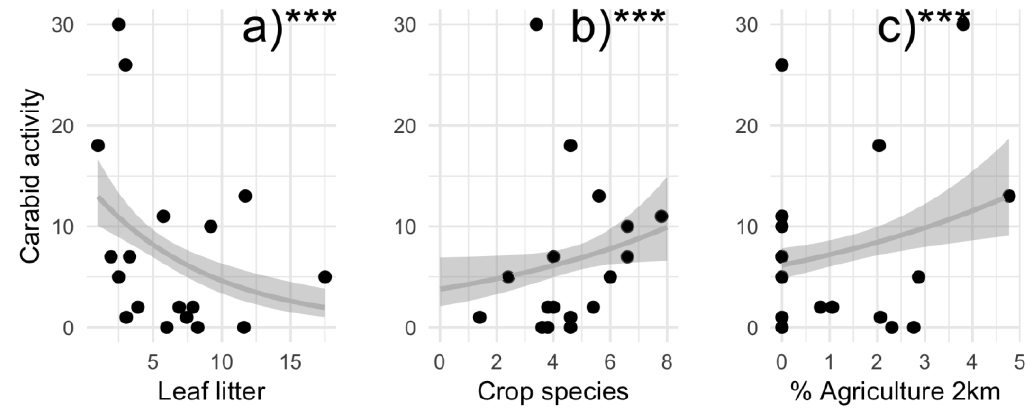
Figure 1. Local and landscape drivers of carabid activity density in urban gardens in the California central coast as determined with generalized linear models. Carabid activity responded to leaf litter ( a ), crop species richness ( b ), and agriculture land cover within 2 km surrounding gardens ( c ).